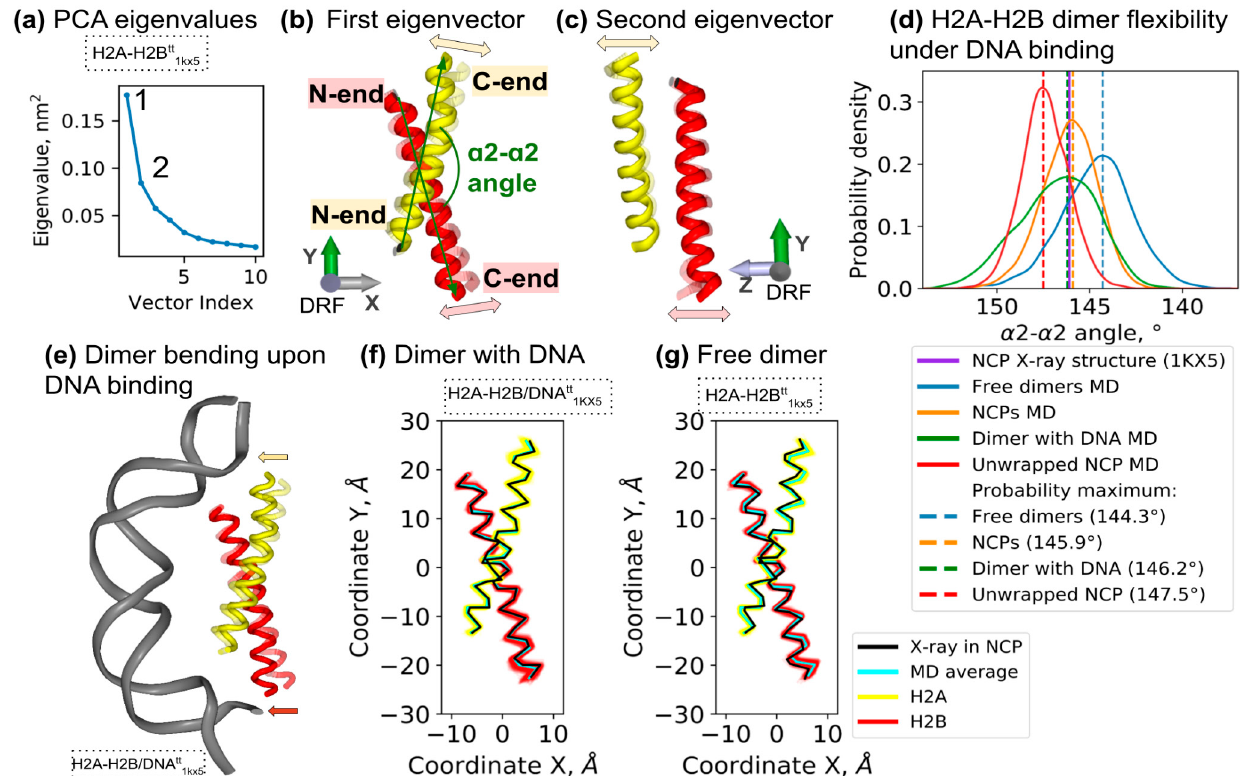
Figure 3. Intrinsic H2A-H2B dimer bending and effects of interaction with DNA. ( a – c ) Principal component analysis of histone α 2-helices’ C α -atoms thermal fluctuations in MD. ( a ) Eigenvalues of the first 10 eigenvectors. ( b , c ) Dynamical modes corresponding to first and second eigenvectors. Snapshots of two extreme states along the eigenvectors are shown (see Figure S6 and interactive materials for a more detailed view). The angle between the two α 2-helices is shown in ( b ) (see Methods for definitions). ( d ) Probability distributions of α 2- α 2 angle values during MD simulations of different systems: free H2A-H2B dimers (systems H2A-H2B tt 1KX5 and H2A-H2B tt 3LZ0 ), dimer bound to DNA (H2A-H2B/DNA tt 1KX5 ) and NCPs (averaged from NCP 147 , NCP tt 147 , NCP tt 146 , NCP tt 145 ). The dashed vertical lines mark the maximum distributions, and the solid violet vertical line marks the value in 1KX5 X-ray NCP structure. The corresponding plots for all simulated systems are shown in Figure S8. For statistical analysis, see Table S3. ( e ) Schematic representation of H2A-H2B bending upon DNA binding. Arrows mark the direction of the bending. ( f , g ) Two-dimensional projections of histone α2 -helices conformations in MD of free ( f ) and DNA-bound dimer ( g ). The mean helix conformations and conformations in an NCP X-ray structure are shown.